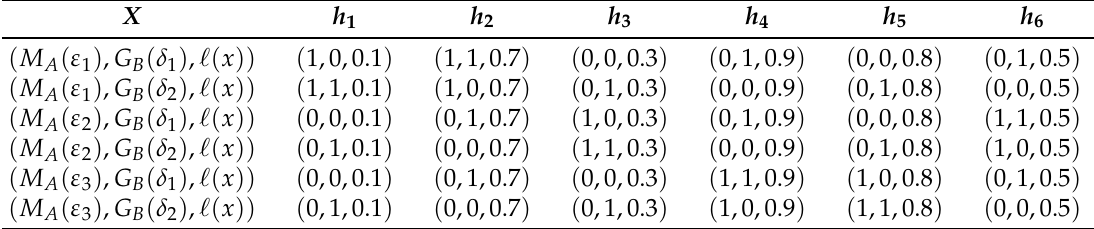
Table 10. Tabular representation of the makgeolli structure M ( A , B , U ) = ( M A , G B , (cid:96) )